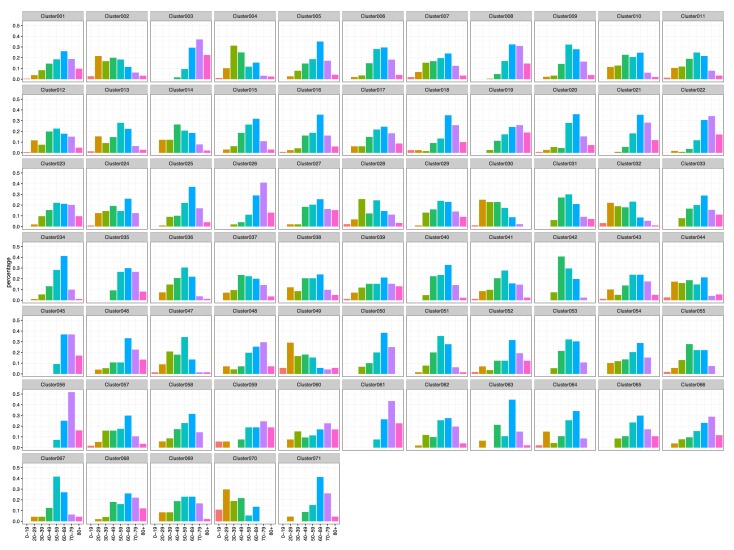
Distribution of age for each cluster.Density diagram of days an individual has been connected to Steno Diabetes Center Copenhagen (SDCC) divided by each cluster. The black line indicates the mean of SDCC connection time for the entire cohort. Some clusters for example Cluster1, show two peaks indicating that there are at least two groups of individuals in a cluster; one connected to SDCC more than the average cohort, and one connected less.